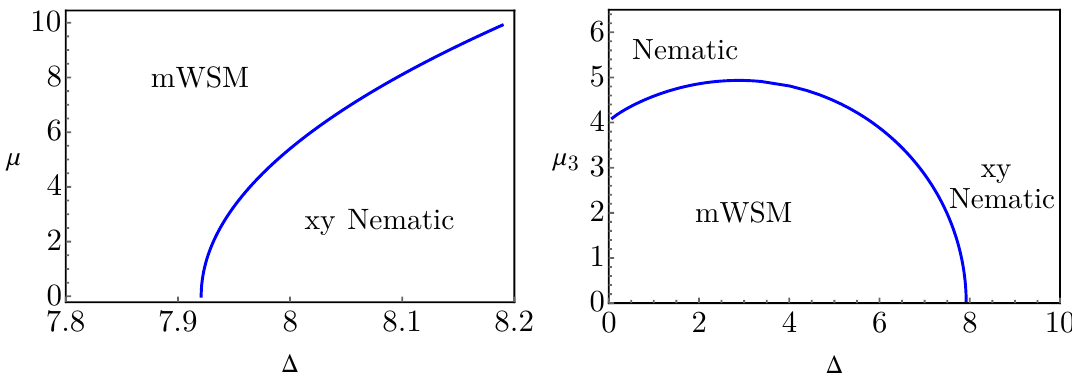
Figure 6 . Phase diagrams at (cid:12)nite (cid:22) (left) and (cid:22) 3 (right). The phase boundaries are represented by the blue